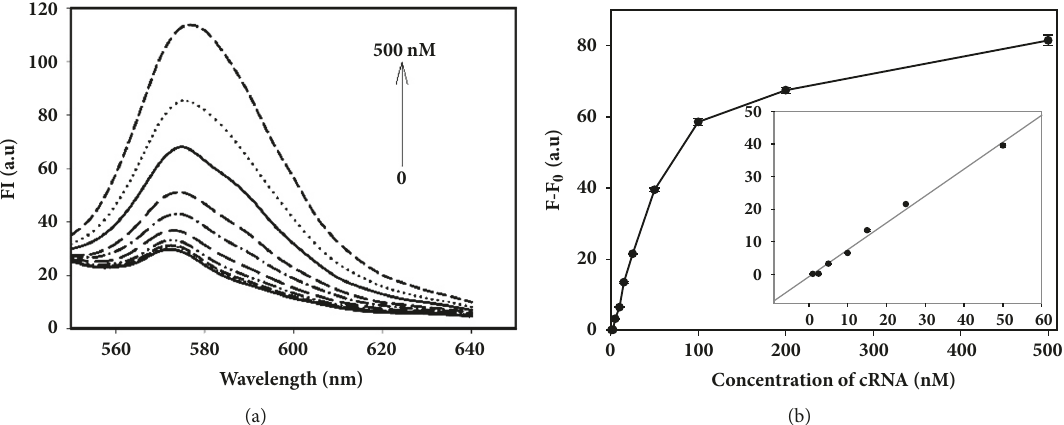
Figure 4: The fluorescence emission spectra of miR21-MB with miR21 (a) and the detection standard curve (b).